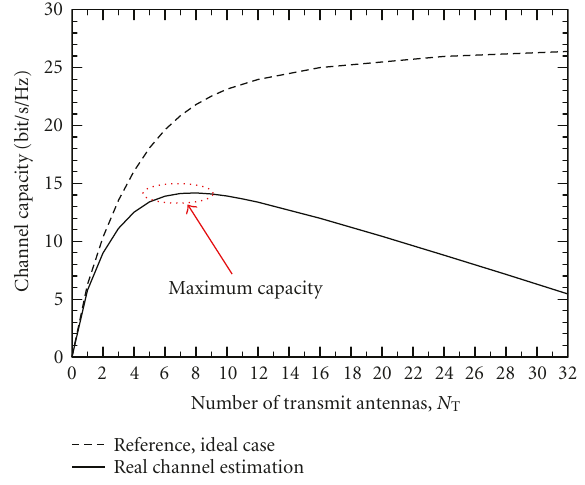
Figure 9: Capacity versus number of transmit antennas N T for MIMO-OFDM system with N R = 8 receive antennas, SNR γ 10 dB, D f = 6, D t = 8, M f = 16, M t =